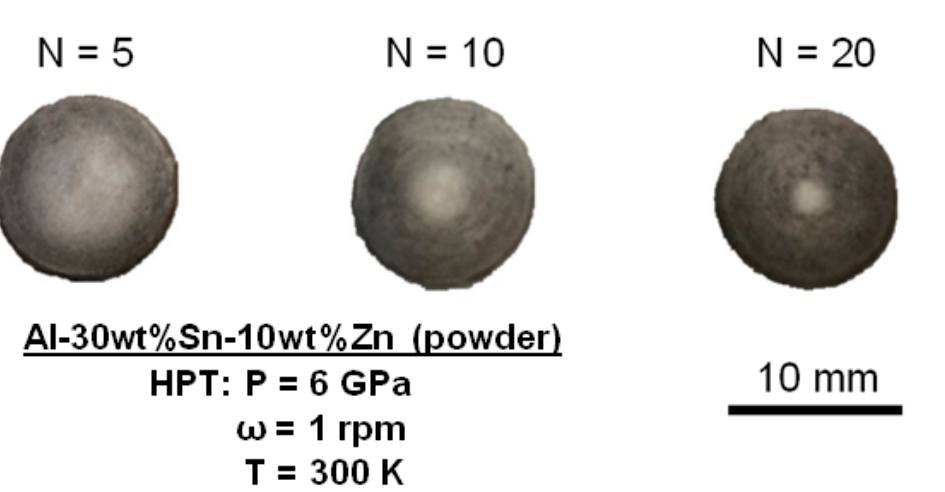
Figure 5. Appearance of Al-30wt % Sn-10wt %Zn discs after HPT processing of powders for N = 5, 10, and 20.